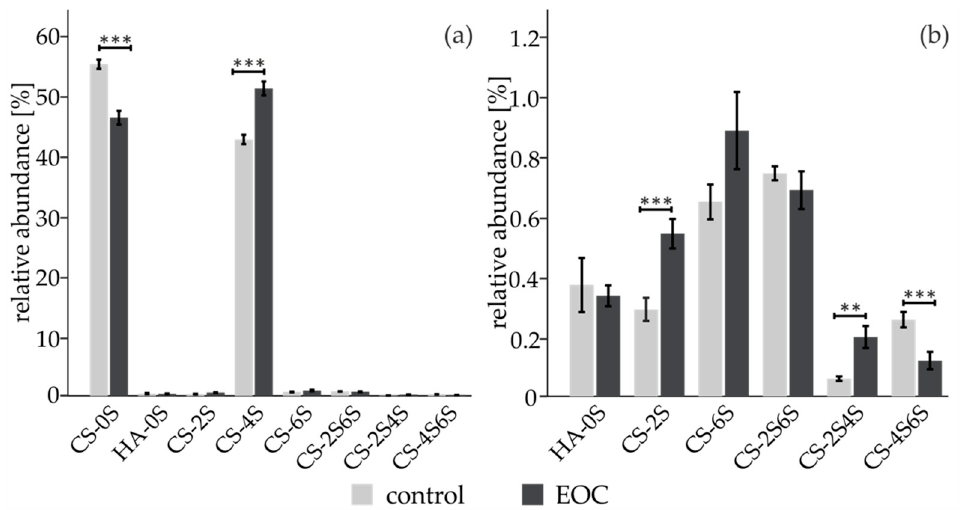
Figure 1. ( a ) Mean and 95% confidence intervals [1] of relative areas of CS disaccharides released from human serum measured by HPLC coupled to fluorescence detection. ( b ) Enlarged view of the low abundant CS disaccharides. * p < 0.5, ** p < 0.01, *** p < 0.001 as judged from non-parametric Mann–Whitney U-test. S indicates sulfate and the preceding digit indicates the sulfation position.